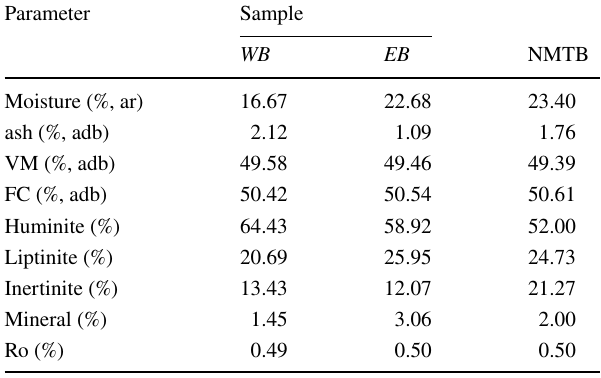
Table 2 Results of proximate analysis of coal samples